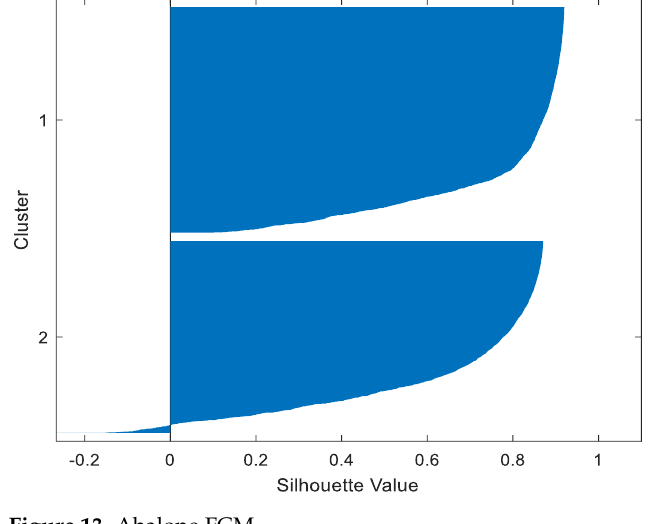
Figure 13. Abalone FCM.